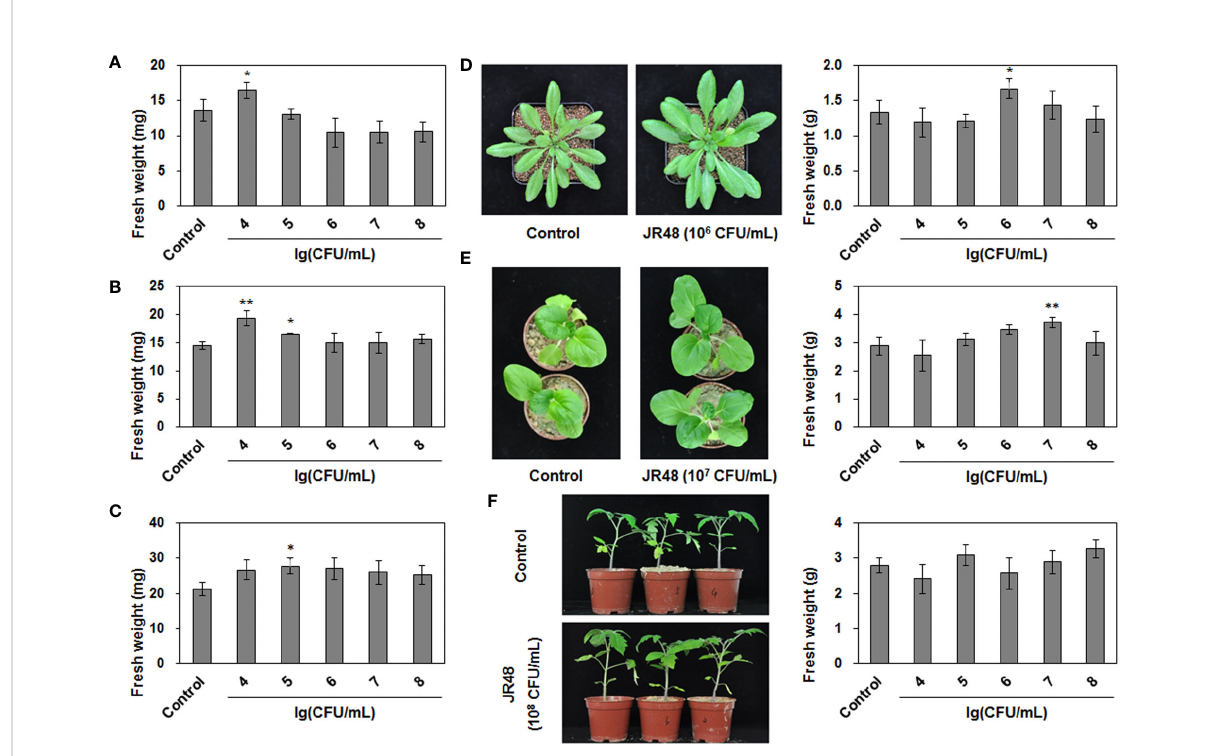
FIGURE 1 PGP effects of JR48 on plants. (A-C) Seedling growth under JR48 treatment. Seedlings of Arabidopsis (A) , Chinese cabbage (B) , and tomato (C) were treated with sterile water (control) or indicated bacterial suspensions of JR48 at different concentrations. Fresh weight were measured and calculated at 7 days post treatment. Values are means ± SD (n = 30; *P < 0.05 and **P < 0.01 compared with control, Dunnett ’ s test). Experiments were repeated in triplicate. (D-F) Plant growth under JR48 treatment. Arabidopsis (D) , Chinese cabbage (E) , and tomato (F) plants were treated as described above. Representative photographs (left panel) were taken at 14 days post treatment and fresh weight were measured at the same time. Values are means ± SD representative of three independent biological replicates (n = 20; *P < 0.05 and **P < 0.01 compared with control, Dunnett ’ s